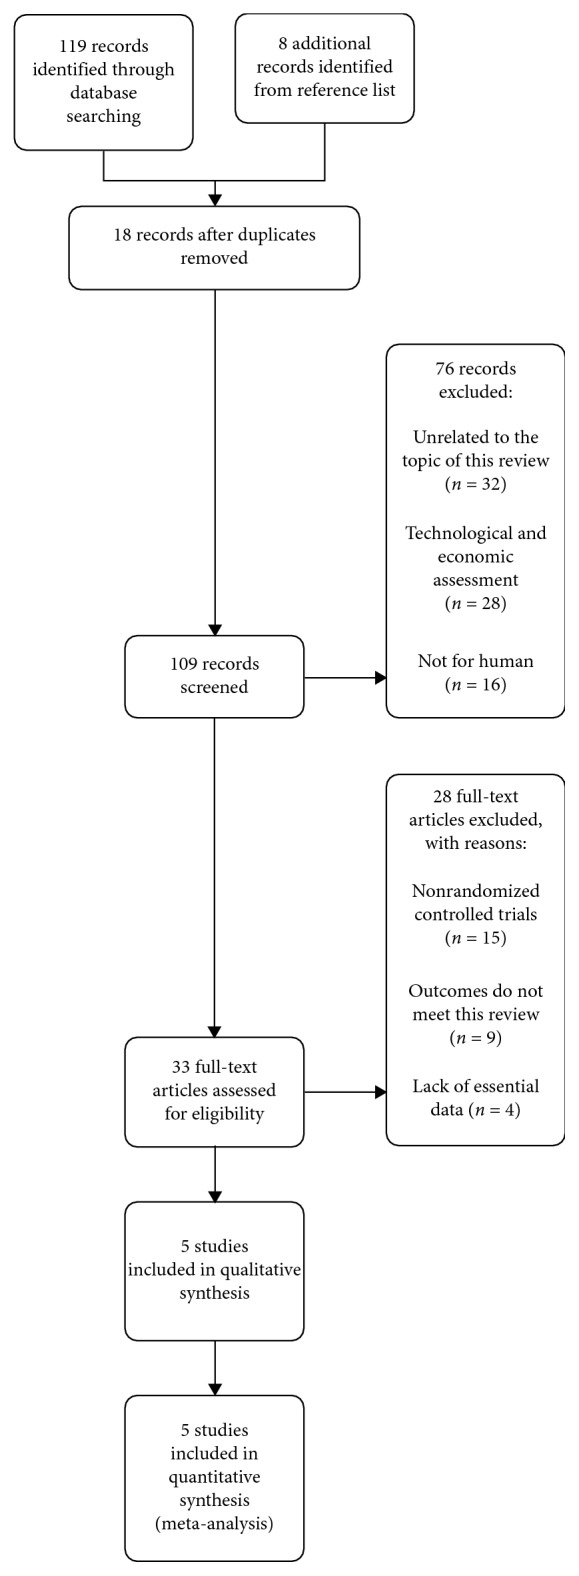
The graph showing a flow diagram of detailed search and exclusion criteria.